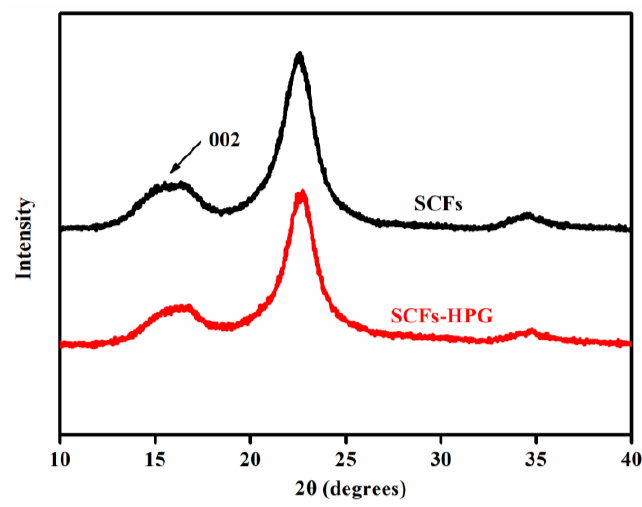
Figure 4. X-ray diffraction (XRD) pattern of SCFs and SCFs-HPG.